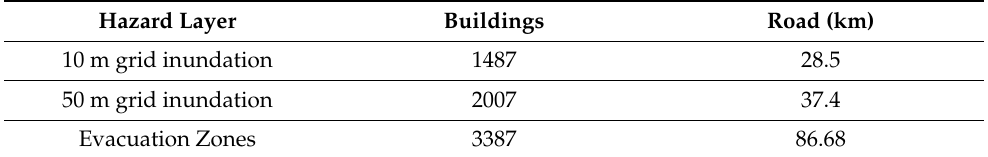
Table 3. Comparison of total features exposed along southeast Upolu based on different hazard